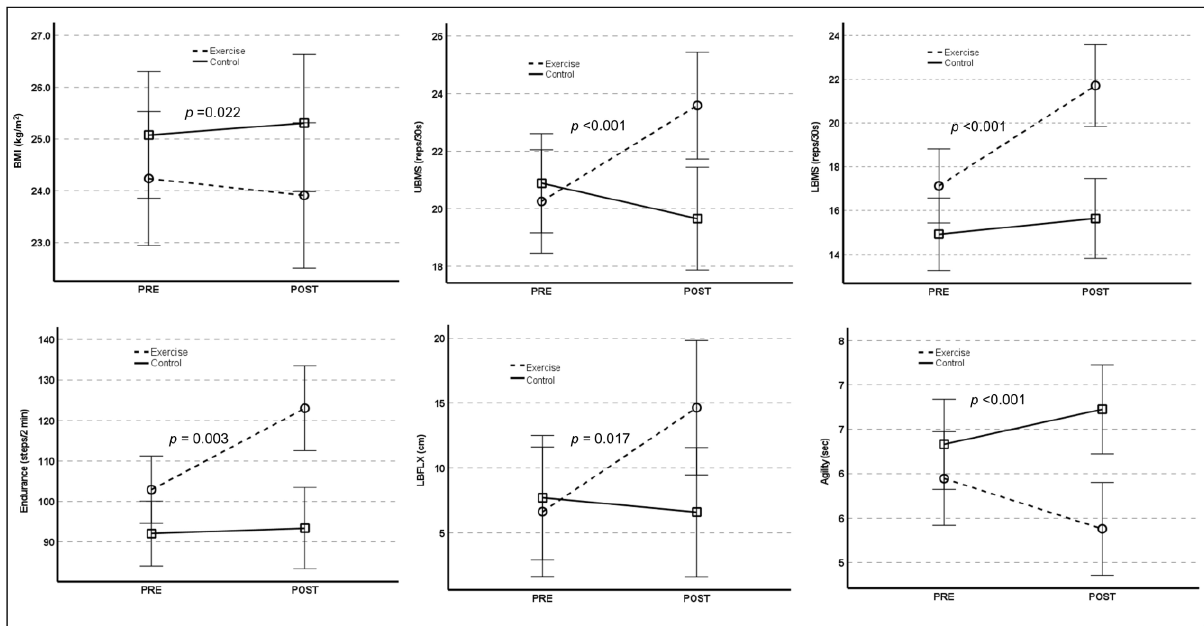
Figure 2. Time-by-group interactions for cognitive function ( left ) and depressive symptoms ( right ). MMSE: Mini–Mental state examination; GDS: geriatric depression scale.